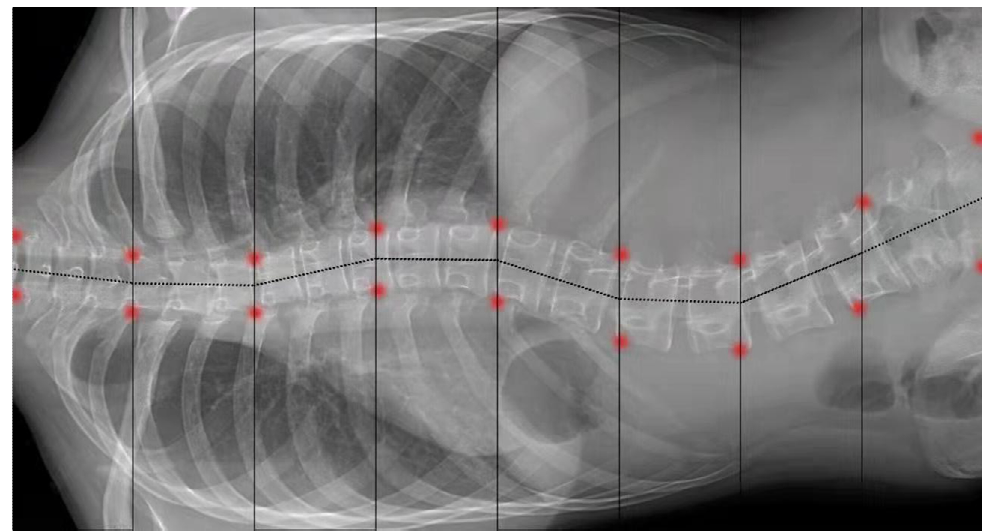
Figure 2. Schematic of octa segmentation method proposed by Chockalingam, N. et al. [42].